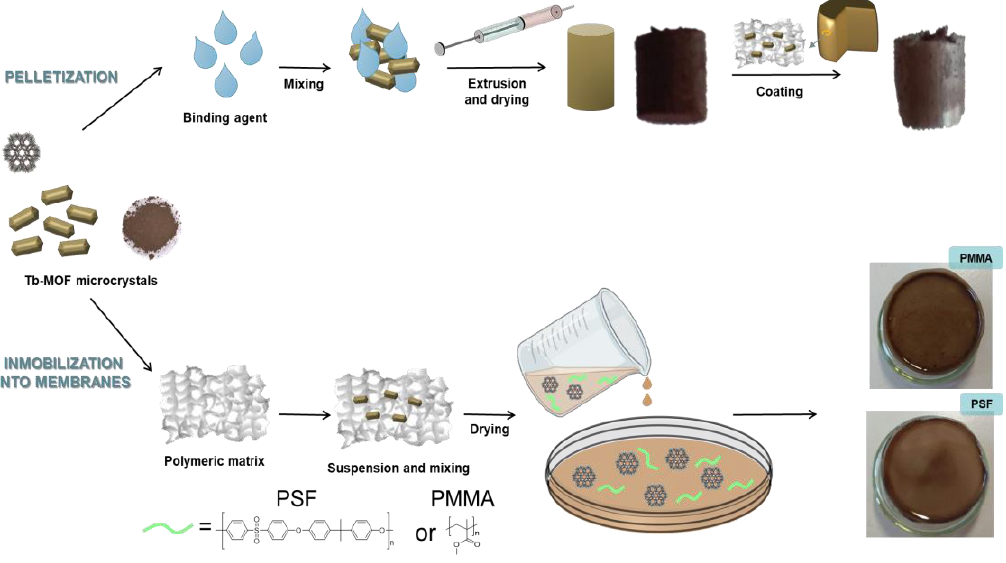
Scheme 1. Representation of the pelletization and membrane immobilization of compound 1